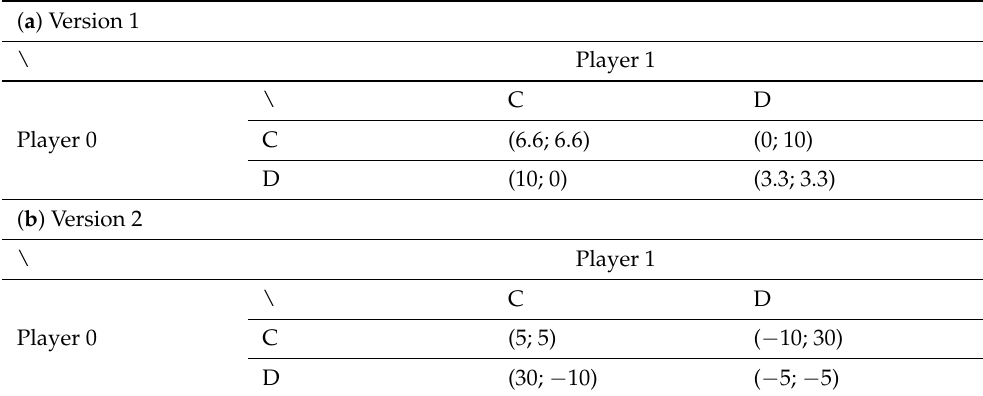
Table 2. Prisoner’s Dilemma payoff matrix representation (e > a > g > c and d > b > h > f).